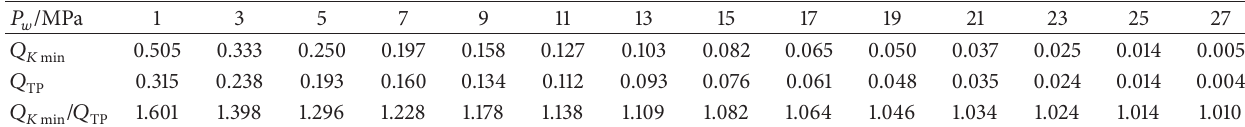
Table 4: Comparison of production at turning point and production at minimum permeability under different wellbore pressure (the gas production rate unit: × 10 4 m 3 /d).